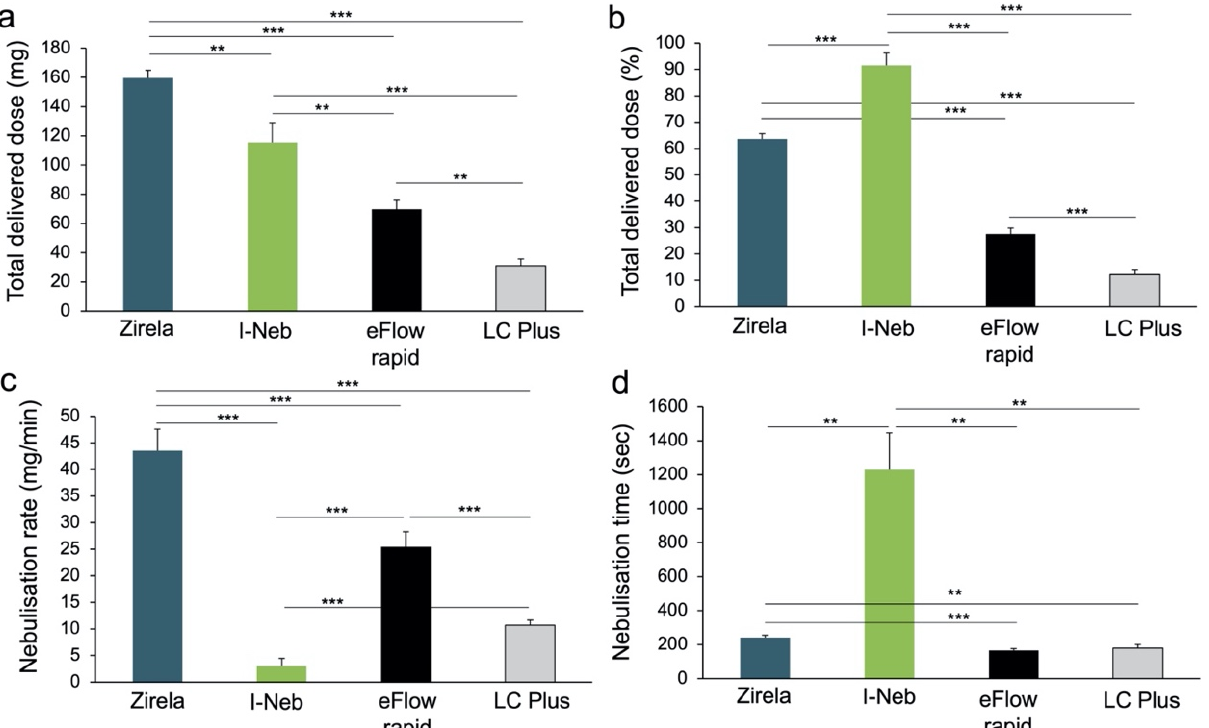
Figure 1. Outcomes of the delivered dose and delivery rate experiments. ( a ) Delivered dose, ( b ) percentage of the delivered dose, ( c ) nebulisation rate, and ( d ) nebulisation time for each nebuliser device. Experiments with Zirela, eFlow rapid and LC Plus were performed loading a full dose of levofloxacin (2.4 mL) into the nebuliser chamber. Experiments with the I-Neb were performed filling the nebuliser chamber with levofloxacin up to its maximum capacity (1.5–1.7 mL filling volume). Mean ± SD are shown. ** p < 0.01, *** p < 0.0001.